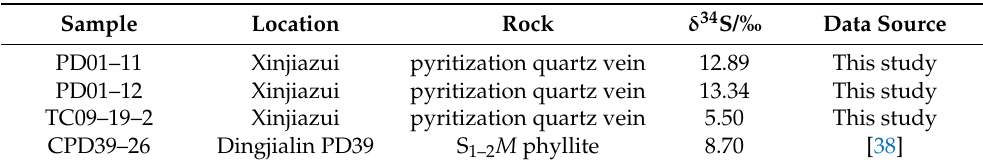
Table 2. Sulfur isotopic composition of pyrite from the Xinjiazui, Dingjialin, and Taiyangping gold deposits.